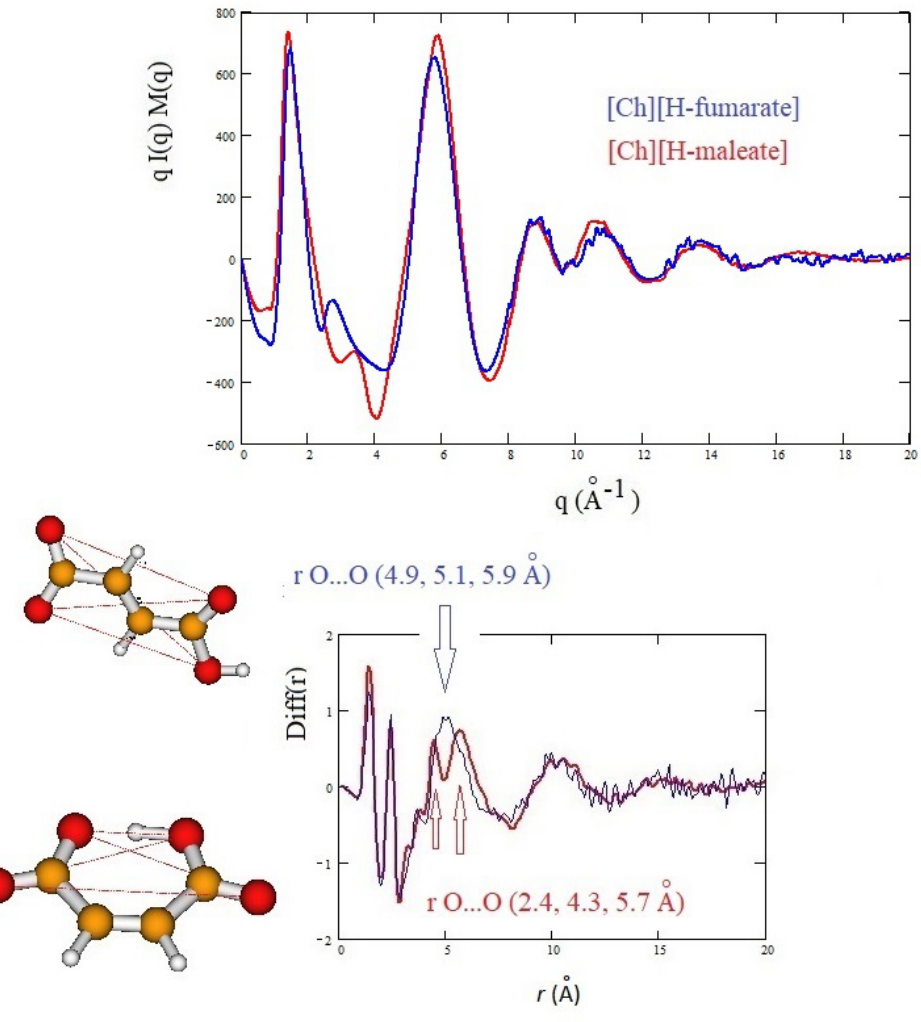
Figure 6. Experimental qI(q)M(q) and Diff(r) curves of [Ch][H-maleate] and [Ch][H-fumarate]; figure shows the intramolecular O· · ·O distances calculated from density functional theory (DFT) geometries of the two